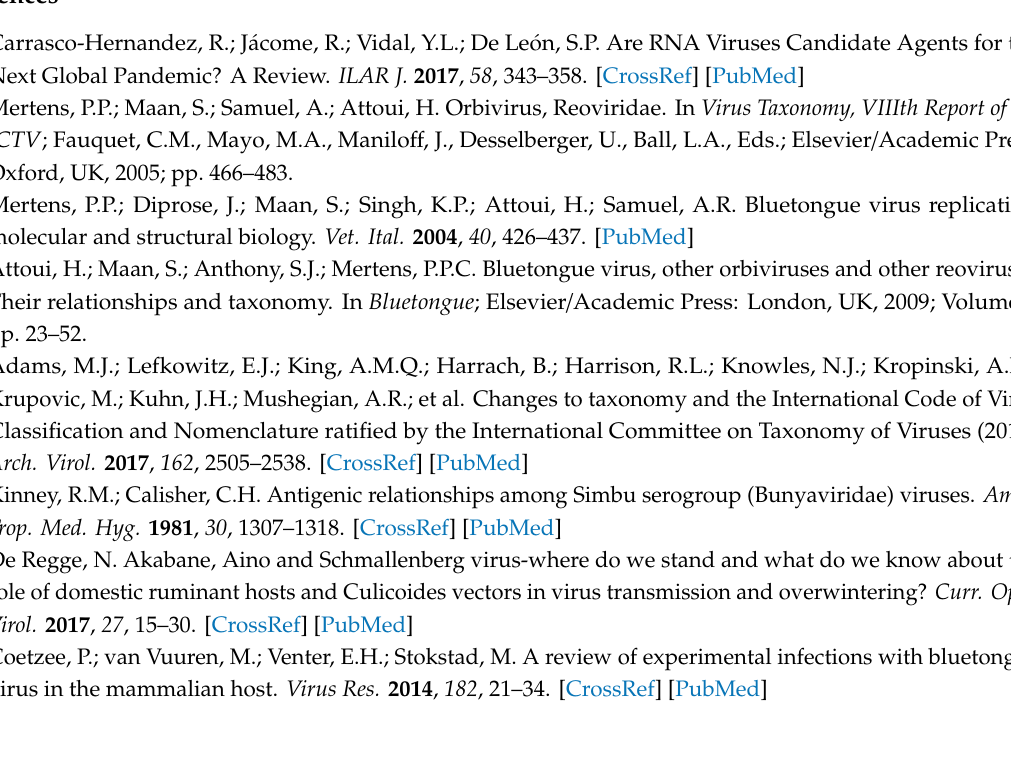
Figure S1: Schematic suggested timeframe for SBV (A) and BTV (B) in utero infection causing defects in cattle and small ruminants’ o ff spring